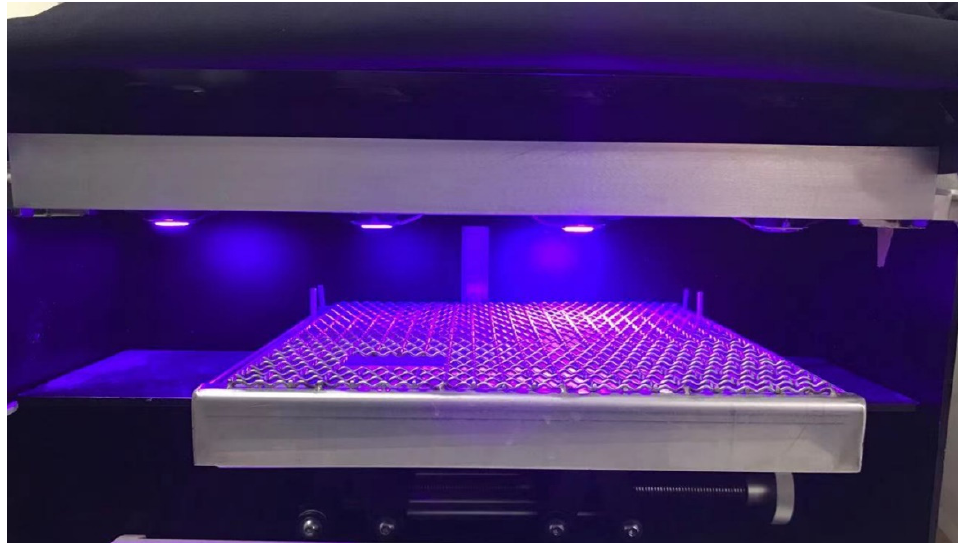
Figure 6. Light emitting diode devices and retaining cages of blue light (410 nm). At the end of the experiment, the animals were sacrificed. Next, 2 ′ ,7 ′ -dichlorodihy- drofluorescein diacetate (DCF-DA) for cellular reactive oxygen species (ROS), enzyme- linked immunosorbent assay (ELISA) for malondialdehyde (MDA), immunofluorescent staining for NOD2, and terminal deoxynucleotidyl transferase-mediated dUTP-nick end labeling (TUNEL) staining for apoptosis were performed. In addition, corneal fluorescein staining (CFS) scores were calculated using slit lamp bio-microscopy, while the expression of ATG16L1, light chain 3-II (LC3-II), and p62 were measured using Western blot after 10 days of blue light exposure. Each group consisted of 10 animals, and the experiments were performed on three independent sets of mice. 4.2. Measurement of ROS Production in the Cornea and Conjunctiva ROS levels were evaluated in corneal and conjunctival tissues (6 eyes per group) us- ing a DCF-DA assay. Whole corneal and conjunctival tissues were surgically harvested, cut into pieces, and incubated at 37 °C for 45 min in the presence of 0.5 mg/mL collagenase type D (Roche Applied Science). Following incubation, the samples were crushed to break through a cell strainer with a pore size of 100 μ m. The cells were washed with PBS and incubated in the dark with 10 μ m DCF-DA (cat. no. D399; Molecular Probes; Thermo Fisher Scientific, Inc) for 30 min at 37 °C. The intensity of fluorescent staining was meas- ured using a FACSCalibur cytometer (BD Biosciences), and the results were shown as the mean percentage increase of DCF-DA fluorescence over the control tissue using Cell Quest software (version 5.2.1; BD Biosciences). 4.3. ELISA Protein levels of lipid peroxidation markers, MDA, were detected using ELISA. The tissues (6 eyes per group) were collected and pooled in lysis buffer containing protease inhibitors for 30 min. Cell extracts were centrifuged at 13,000 × g for 10 min at 4 °C, and the supernatants were stored at − 70 °C until use. Following that, 25 μ L of total protein from each sample was pipetted into the assay for MDA (Cell Biolabs, San Diego, CA) us- ing the ELISA kit (catalog no. STA-832, Cell Biolabs, San Diego, CA, USA). The samples were analyzed according to the manufacturer’s instructions [24,25].